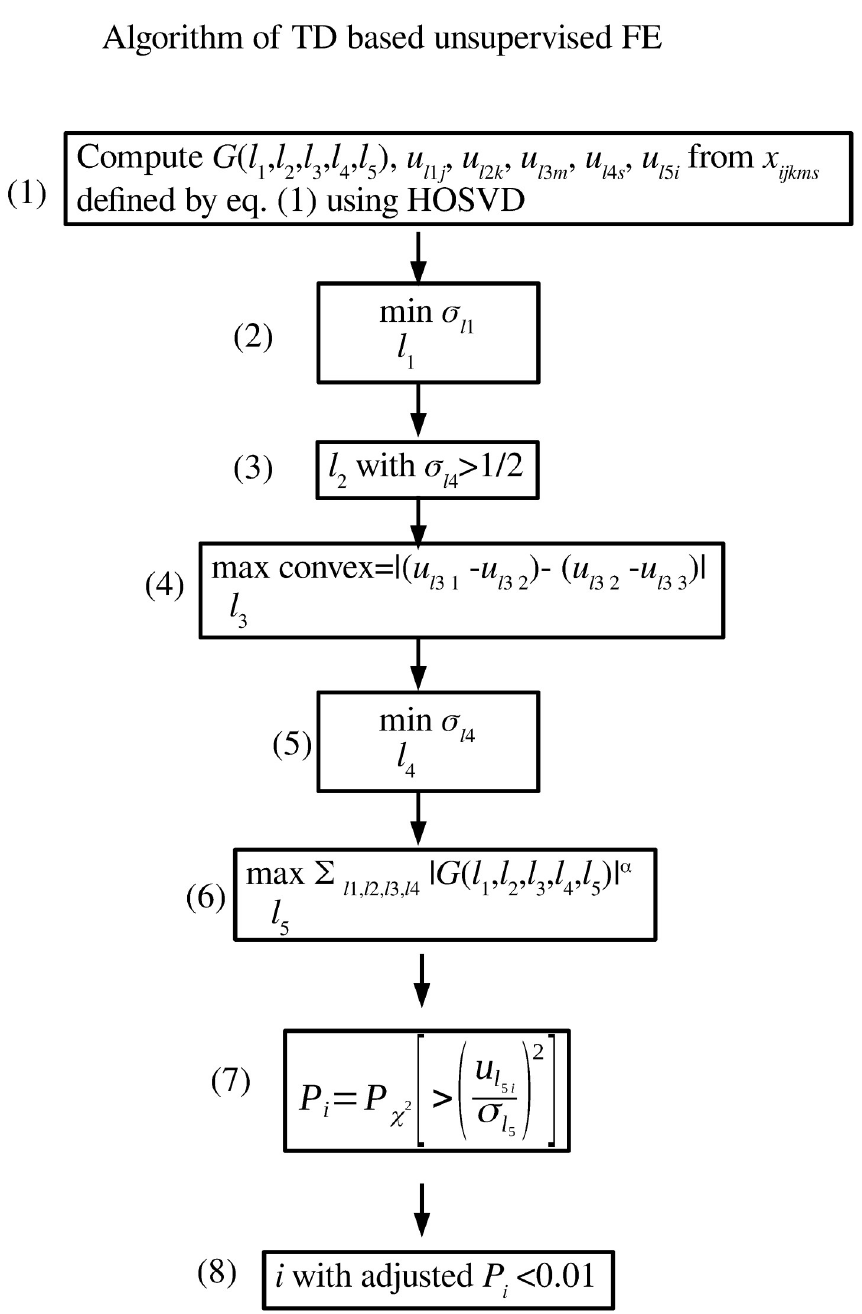
Fig 2. Algorithm of TD based unsupervised FE. (1) Perform TD to derive G ( ℓ 1 , ℓ 2 , ℓ 3 , ℓ 4 , ℓ 5 ). (2) Select u that takes ℓ 1 j constant values between two cell lines as much as possible. (3) Select u ℓ that has distinct values for Histone 2 k modification toward inputs. (4) Select u that represents reactivation during three cell cycle phases as much as ℓ 3 m possible. (5) Select u that takes constant values between two biological replicates as much as possible. (6) Select ℓ 5 ℓ 1 j associated with G having largest absolute values given ℓ 1 , ℓ 2 , ℓ 3 , ℓ 4 (7) Attribute P -values to i s with assuming that u ℓ 5 i obeys Gaussian distribution (Null hypothesis). (8) Select i s associated with adjusted P -values less than 0.01.